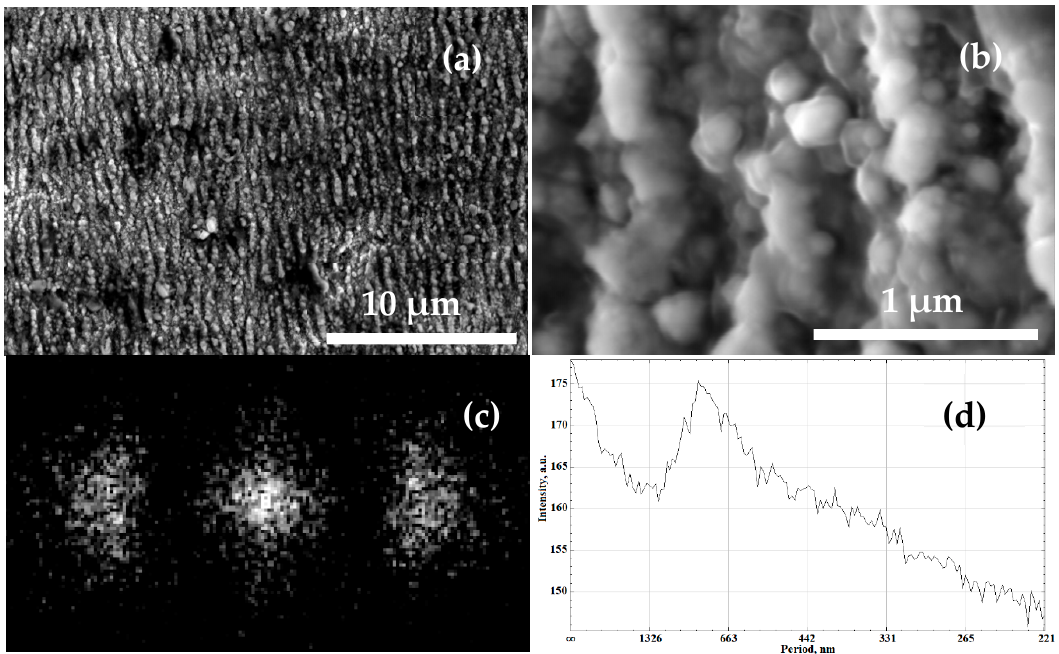
Figure 6. SEM images for 9 J/cm 2 with five scan repetitions. ( a ) Wide shot SEM demonstrating periodic yet loosely regular LIPSS; ( b ) SEM close-up on LIPSS, revealing a granular structure (observed with 52° sample tilt); ( c ) FFT of initial SEM image with contrast enhanced; ( d ) FFT spectrum with the peak clearly visible.